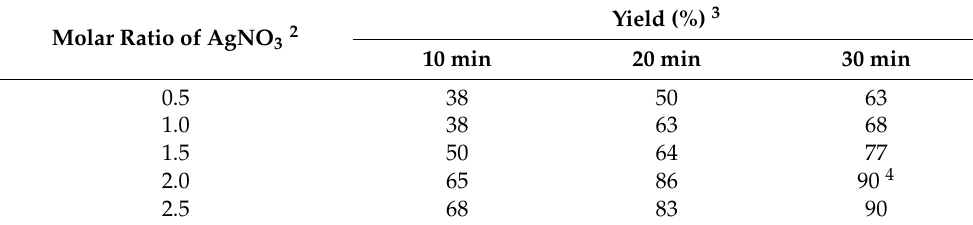
Table 1. Optimization of the iodination of uracil at room temperature 1 .